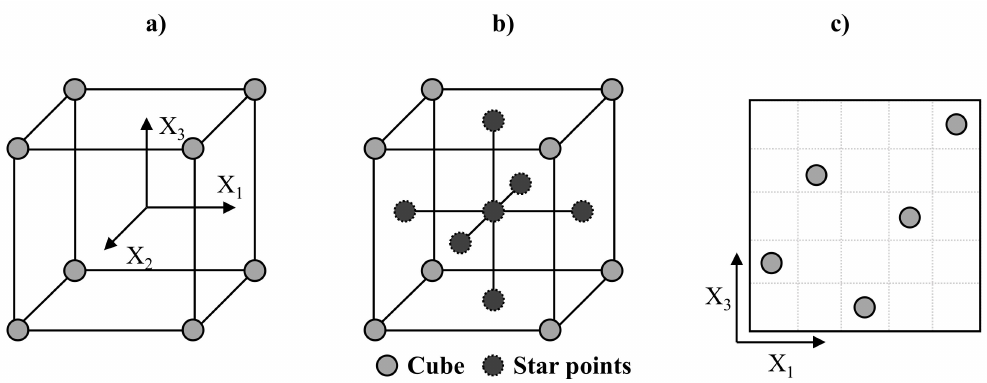
Figure 3. Full factorial plan ( a ) and face centered composite design ( b ) for three factors. Latin hypercube sampling ( c ) for two